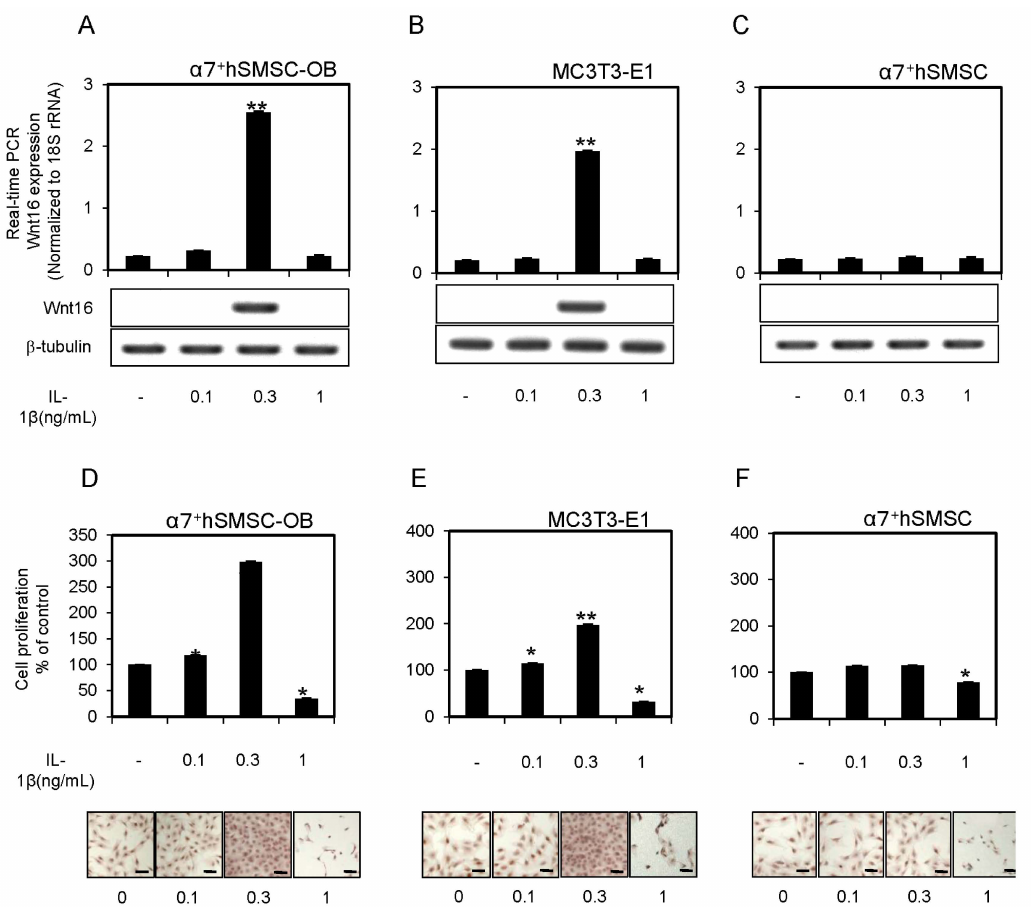
Figure 1. IL-1 β -induced expression of Wnt16 mRNA and protein in α 7 + hSMSC-OB cells, MC3T3-E1 cells, and α 7 + hSMSCs. ( A – C ) Cells were treated with IL-1 β (0, 0.1, 0.3 and 1 ng/mL), followed by real-time qPCR analysis of Wnt16 mRNA expression relative to the control (18S rRNA). Data are the mean ˘ SD of four independent experiments. ** p < 0.01. Western blot analysis of Wnt16 and β -tubulin protein levels was performed following stimulation with IL-1 β ( lower panels). Blots shown are representative of three independent experiments; ( D – F ) Effect of exogenous IL-1 β on cell proliferation in α 7 + hSMSC-OB cells, MC3T3-E1 cells, and α 7 + hSMSCs. The effect of exogenous IL-1 β on cell proliferation as evaluated using the BrdU-cell proliferation ELISA and BrdU immunohistochemistry kit that stains the nuclei of proliferating cells (dark brown; bottom panels). Scale bars = 100 µ m. The cells were incubated in the absence or presence of IL-1 β (0, 0.1, 0.3 and 1 ng/mL) for 24 h. Data are